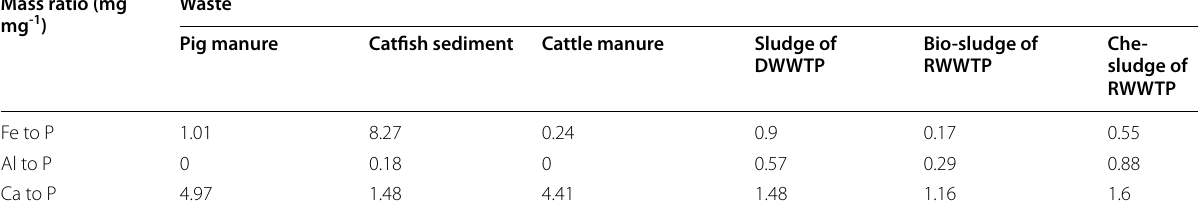
Table 3 Metal to P mass ratio in studied